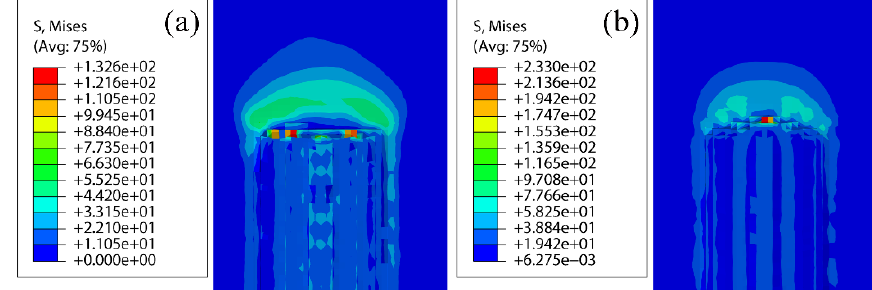
Figure 10. Von Mises of rock under the action of conventional cutter and 3-RDE cutter: ( a ) conventional cutter; ( b ) 3-RDE cutter.